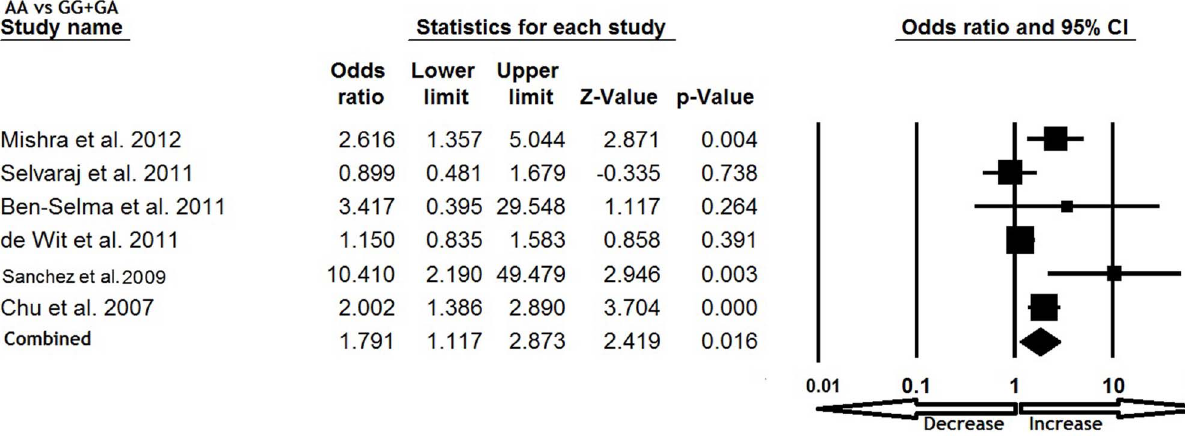
Figure 3. Forest plot and ORs with 95% CI of CCL5 -403G . A polymorphism and TB risk (AA vs. GG + GA).